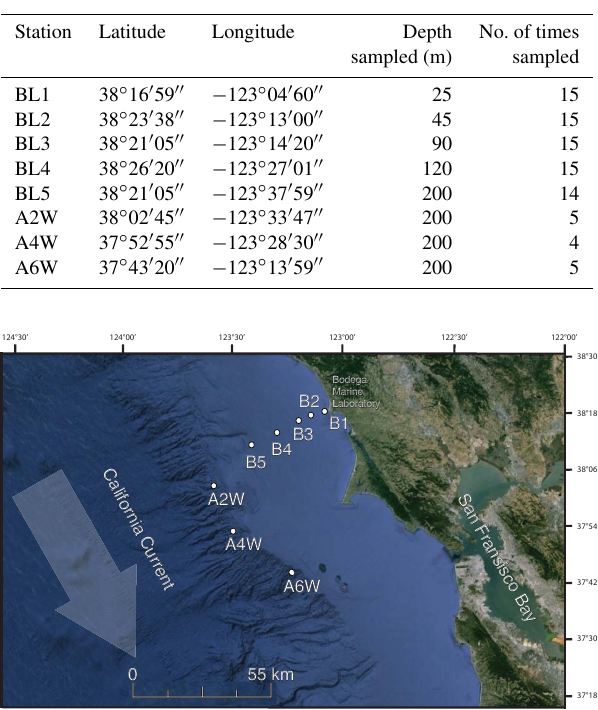
Table 1. Station locations, depths, and the number of times sampled over the course of this study.